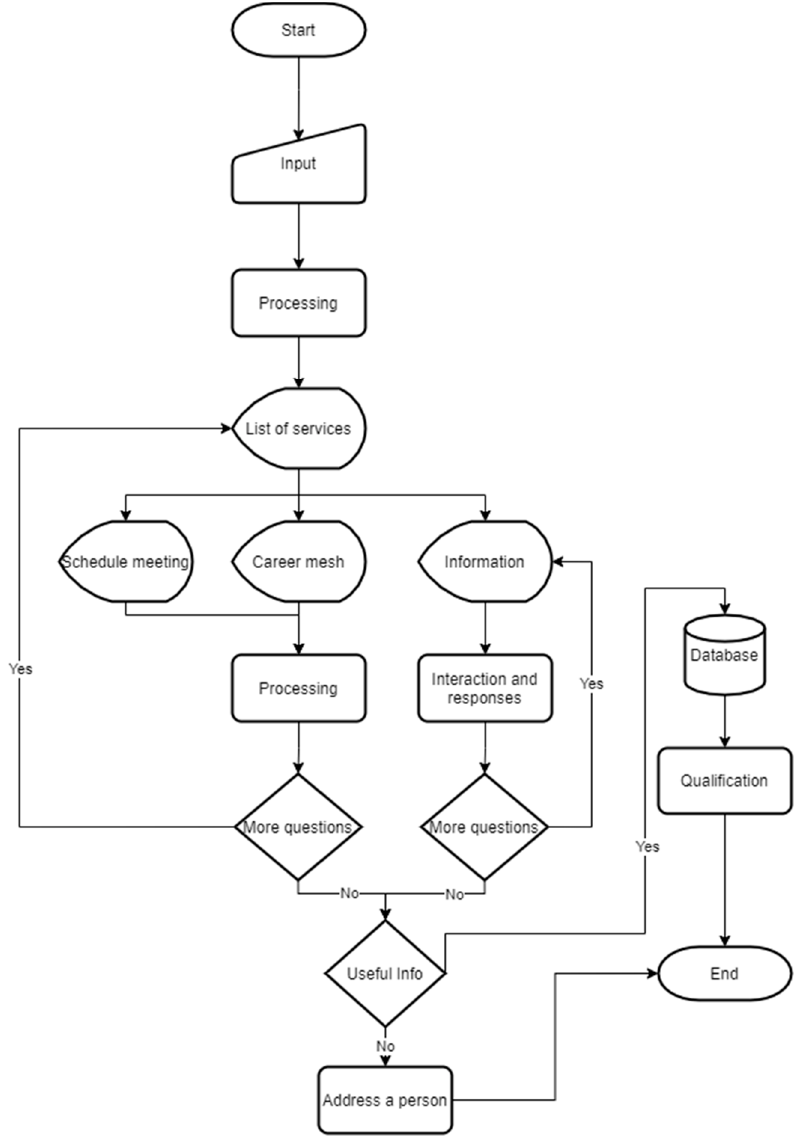
Figure 3. Block diagram of the functioning of a Chatbot applied to academic management.